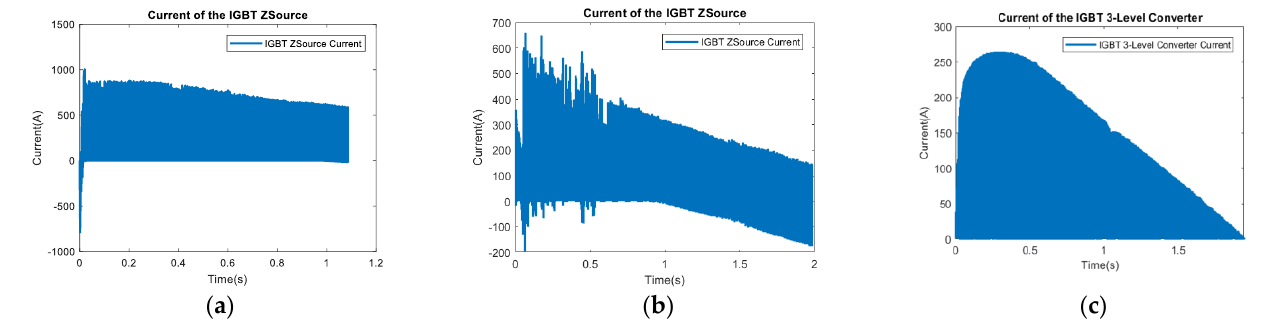
Figure 16. Current flowing in the ST-IGBT of the Z-source in an ( a ) open-loop control, ( b ) closed-loop control, and ( c ) the IGBT modules in a 3-level/SVPWM